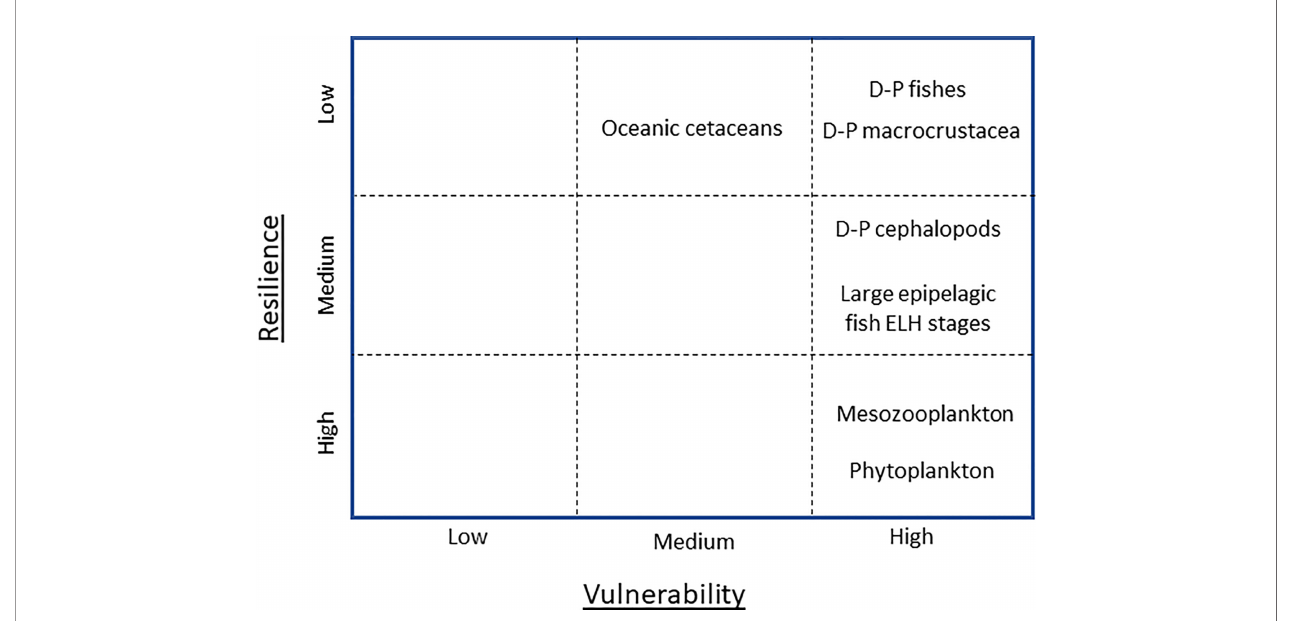
FIGURE 3 | Summary Vulnerability-Resilience matrix, with cumulative attribute designation of high, moderate, and low for key open-ocean taxa of the northern Gulf of Mexico. D-P, deep-pelagic (residing in water column below 200 m depth during